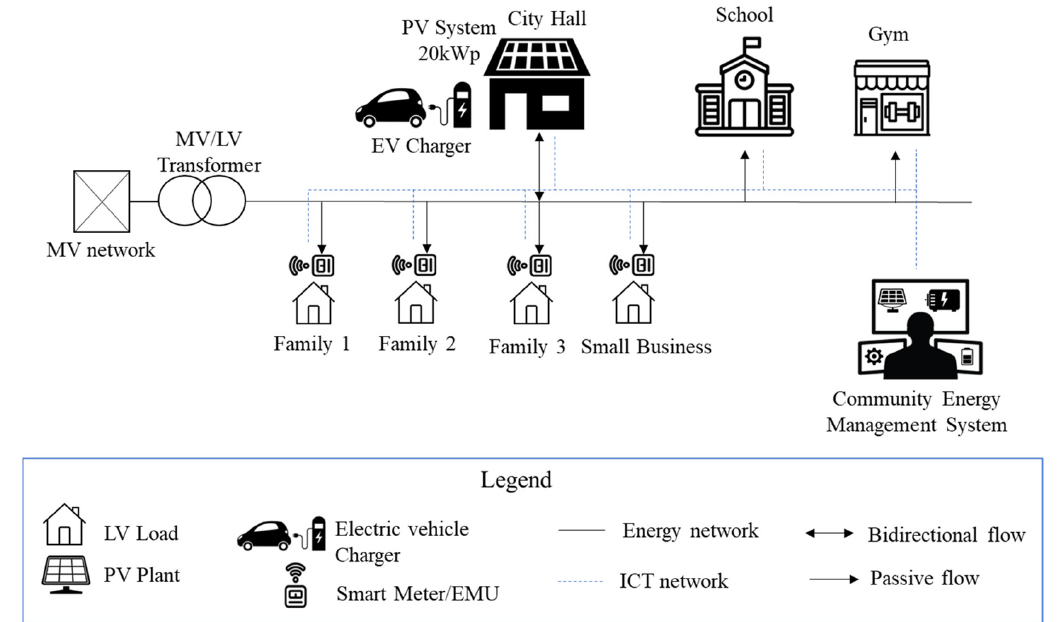
Figure 2. Simplified scheme of the participants of the REC.